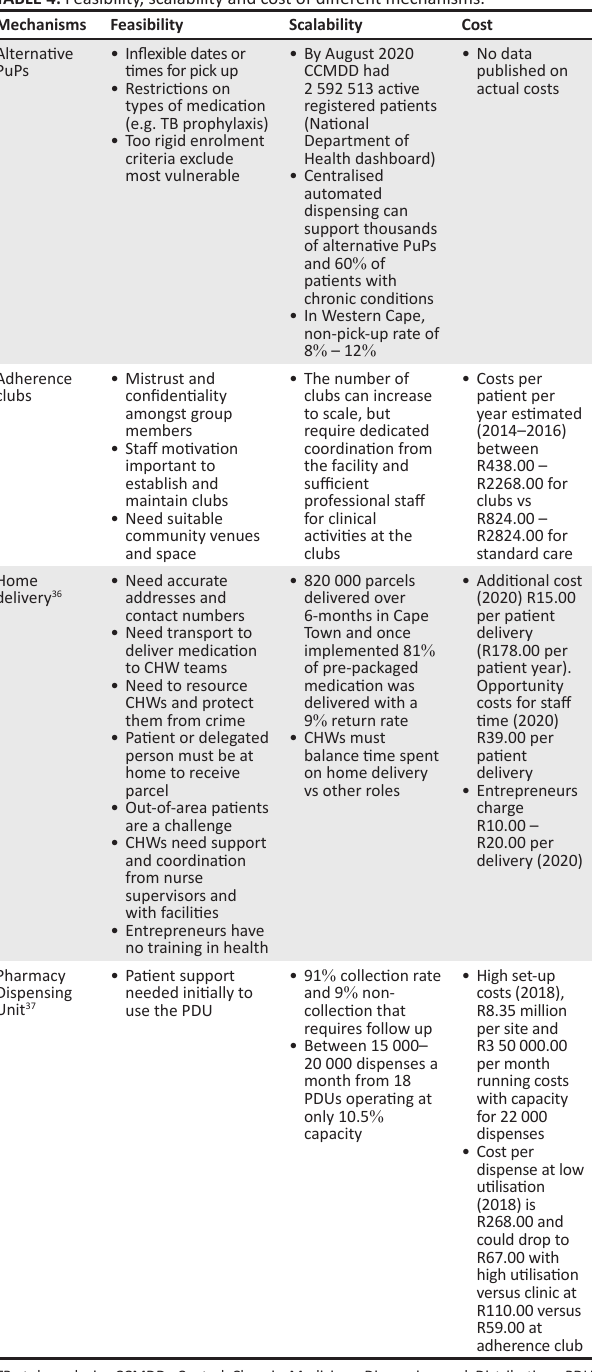
TABLE 4: Feasibility, scalability and cost of different mechanisms. Mechanisms